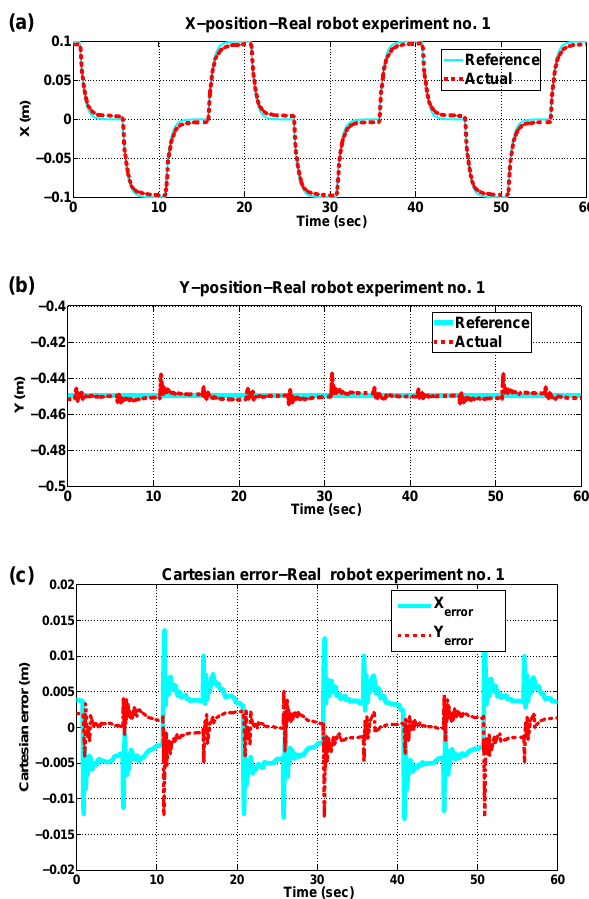
Figure 5. Position x (a) and y (b) and Position errors (c) experi- ment